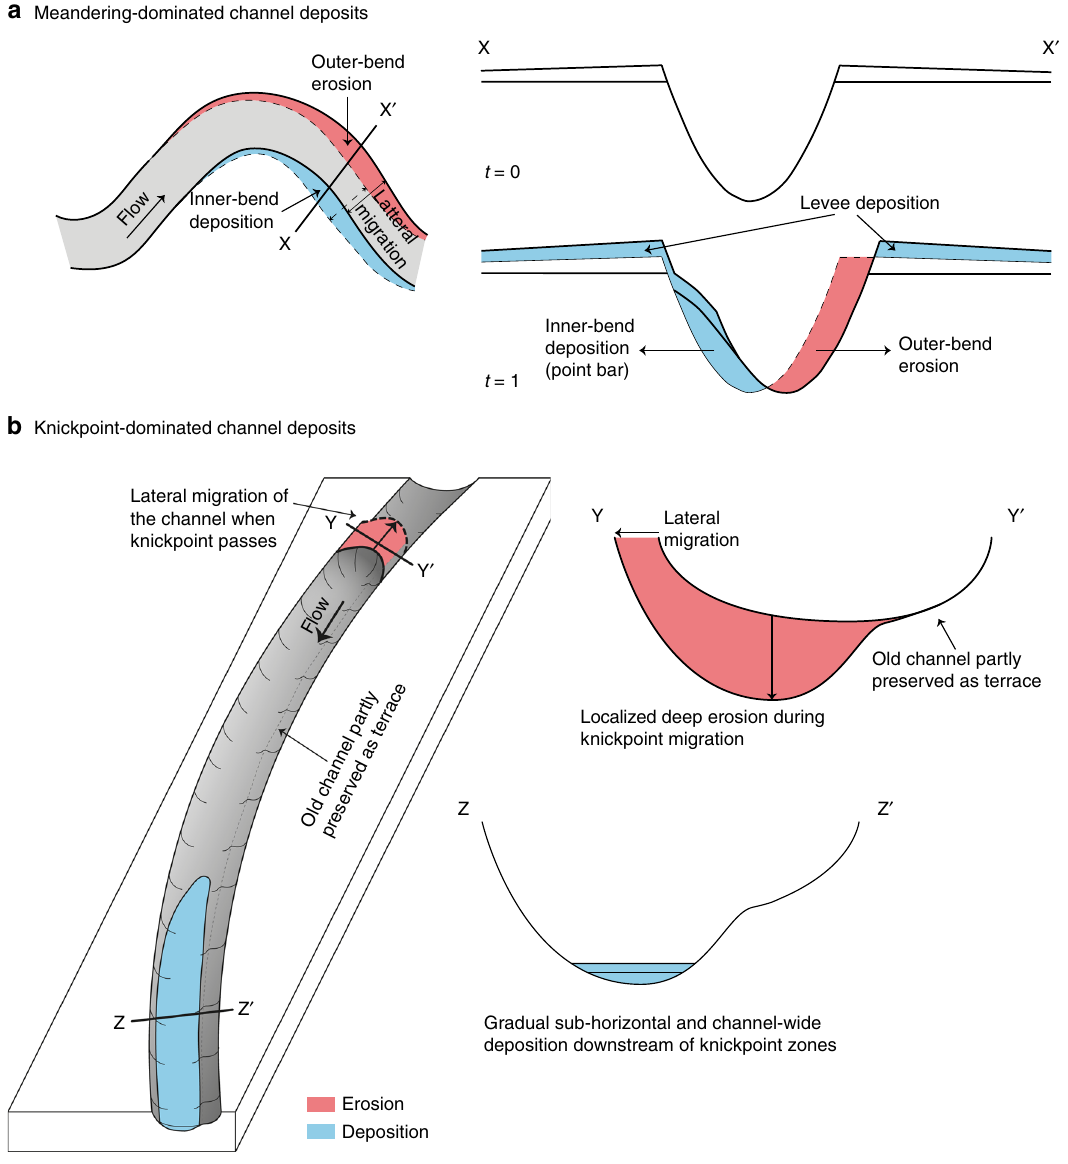
Fig. 9 Generalized models for submarine channel evolution and deposits. a Deposition and erosion in meandering dominated channels (after 23 ). This results in bars (shown in light blue) deposited in the inner bends, and erosion in the outer bends. The erosion causes outward and downstream propagation of bends. b New model for submarine channel deposits in locations dominated by fast-moving knickpoints, such as Bute Inlet. Knickpoint migration causes deep erosion, and potential channel migration. This is then followed by channel-wide deposition, once the knickpoint has migrated further